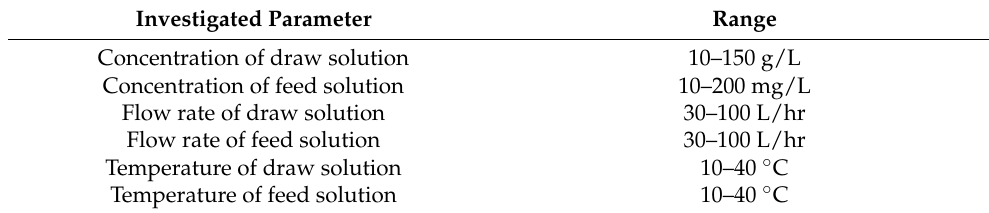
Table 1. Values of process parameters [115].